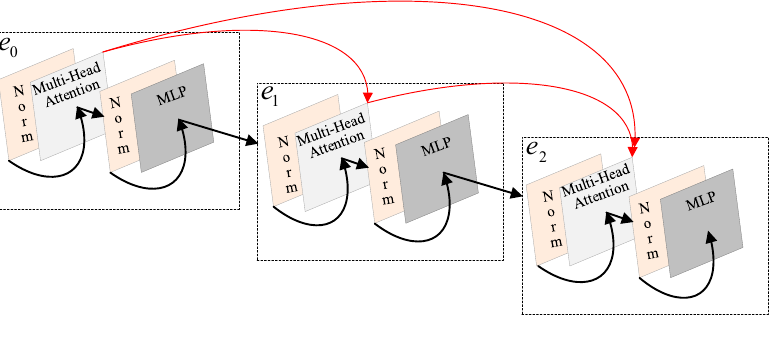
Figure 2. A DenseTransformer. Figure 2. A